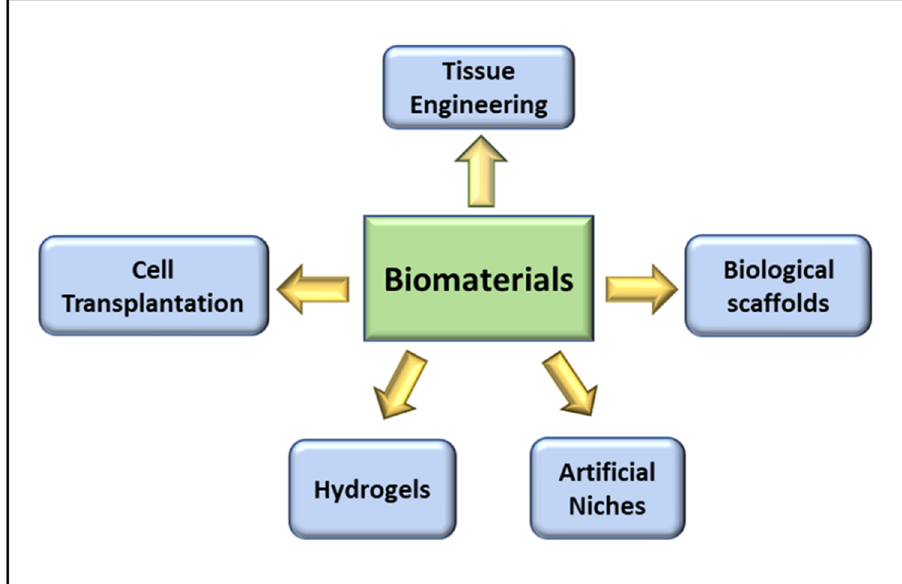
Figure 2. Schematic illustration of current biomaterial approaches for the treatment of VML.